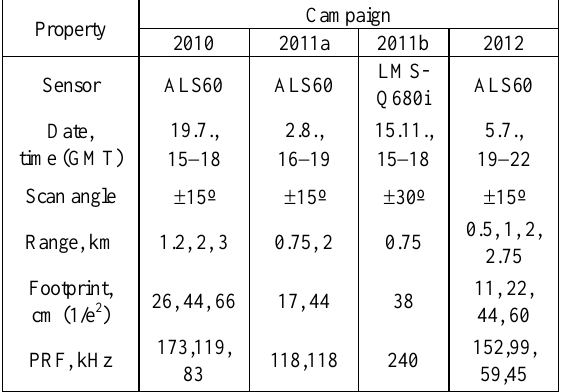
Table 1. Characteristics of the LiDAR acquisitions.